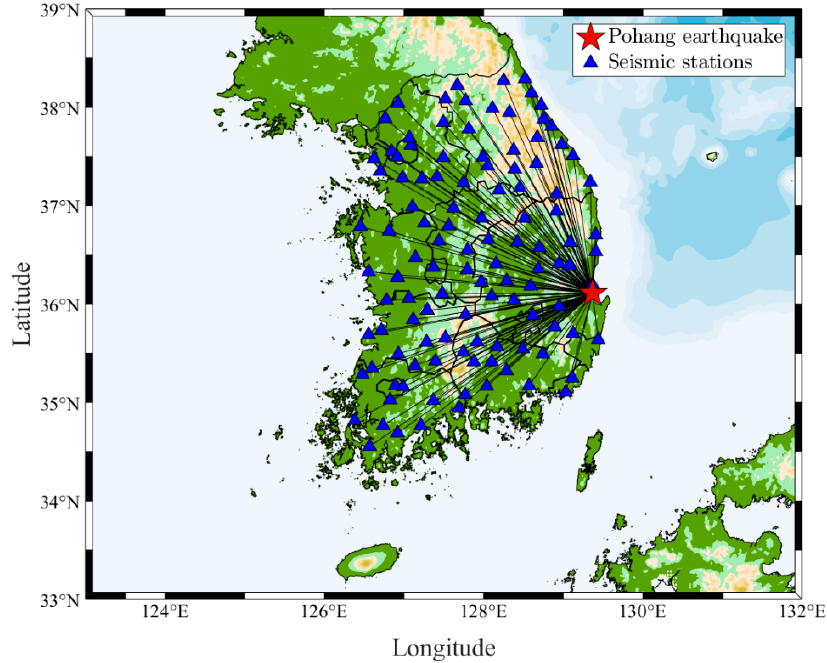
Figure 1. The 2017 Pohang earthquake and seismic recording stations with ray path lines.